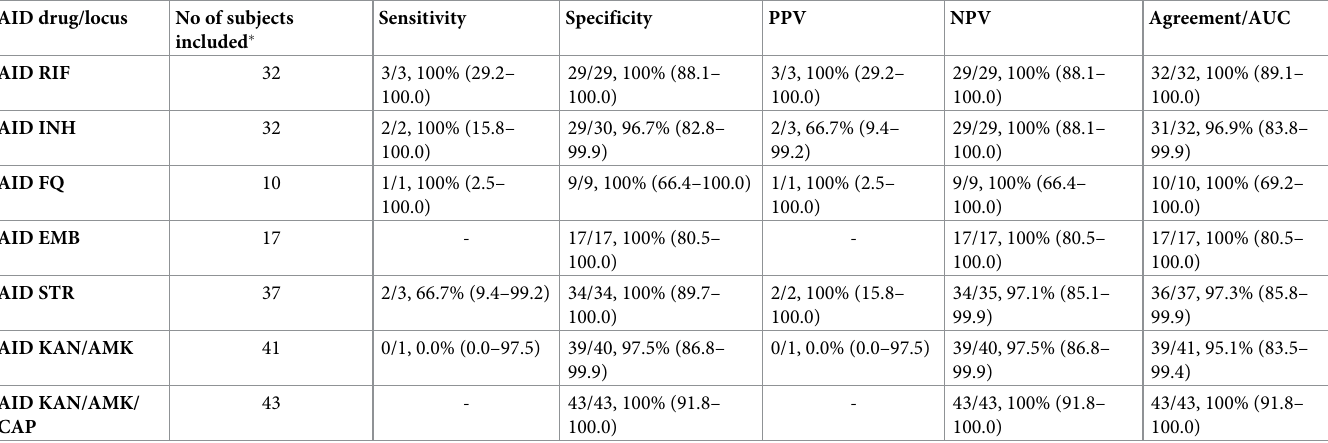
Table 3. Resistance detection by AID-modules versus DST in culture as reference